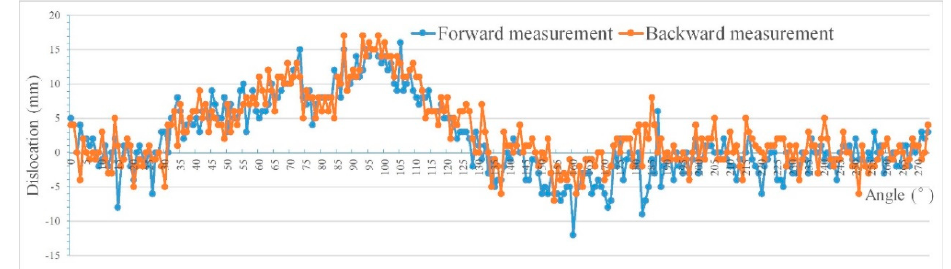
Figure 9. Dislocation of the forward and backward measurements.